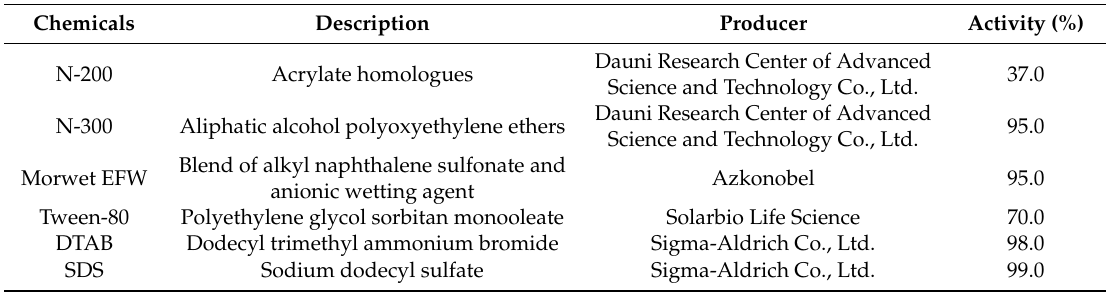
Table 1. Information for six